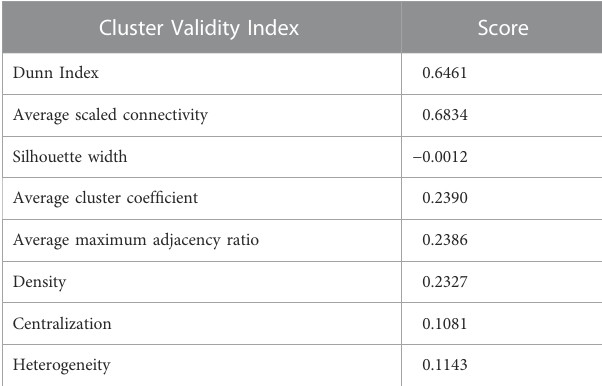
TABLE 2 Cluster Validity Index measures of our experiment.